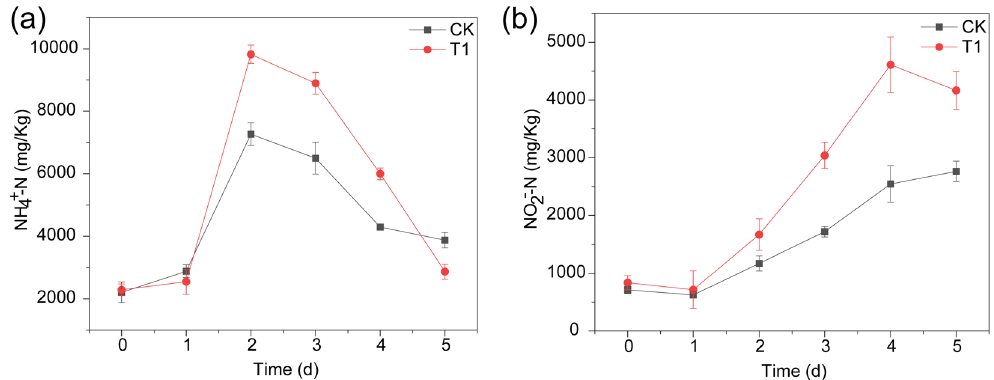
Figure 4. Profiles of NH 4+ -N (a) and NO 2– N (b) during the fermentation process of CK and T1. The data represent the means ± standard deviations from three